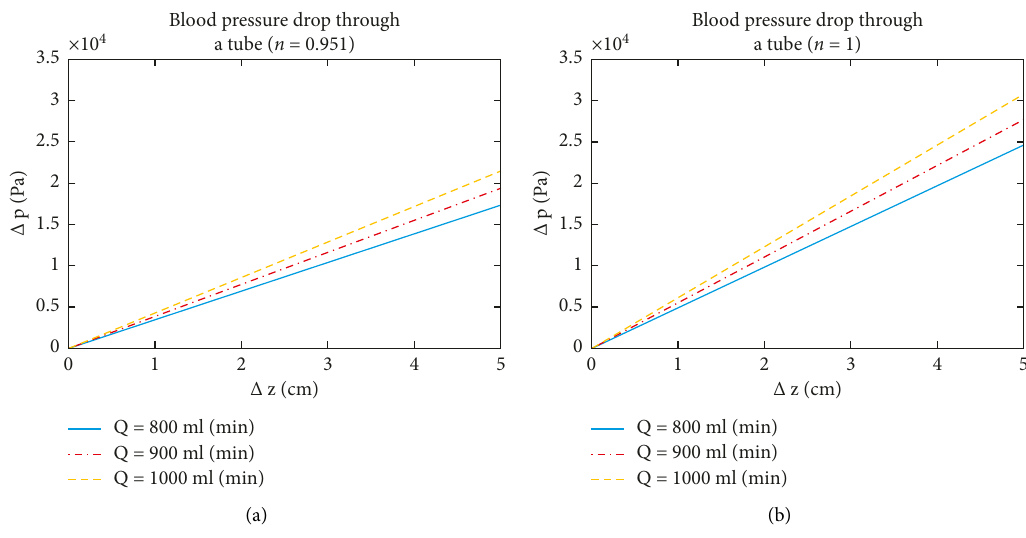
Figure 3: (a) Relation between Δ p ( Pa ) and Δ z ( cm ) . (b) Relation between Δ p ( Pa ) and Δ z ( cm )